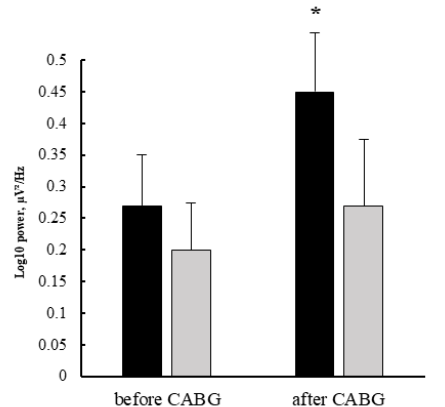
Figure 2. Differences in the theta2-rhythm power of EEG resting state with eyes closed in patients who underwent on-pump CABG, depending on the presence of CA stenoses less than 50%: dark columns—the patients with CA stenoses, light columns—the patients without CA stenoses, error bars denote SE, *— p < 0.05 Newman–Keuls multiple comparison test.